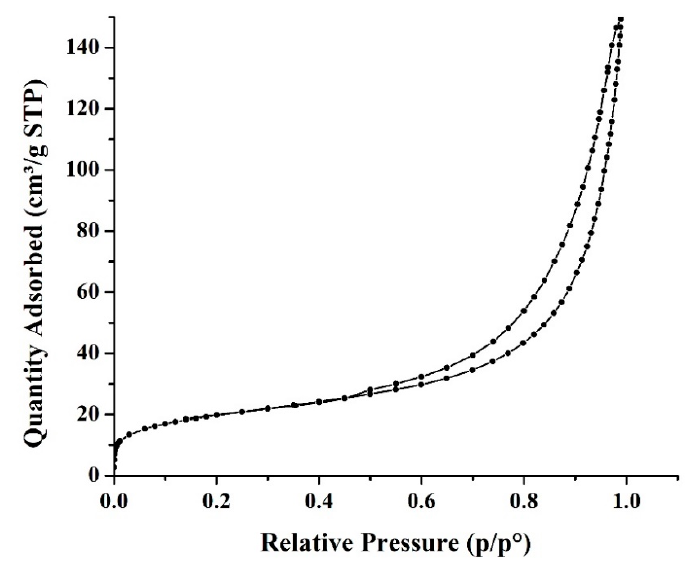
Figure 7. N 2 adsorption-desorption isotherms.